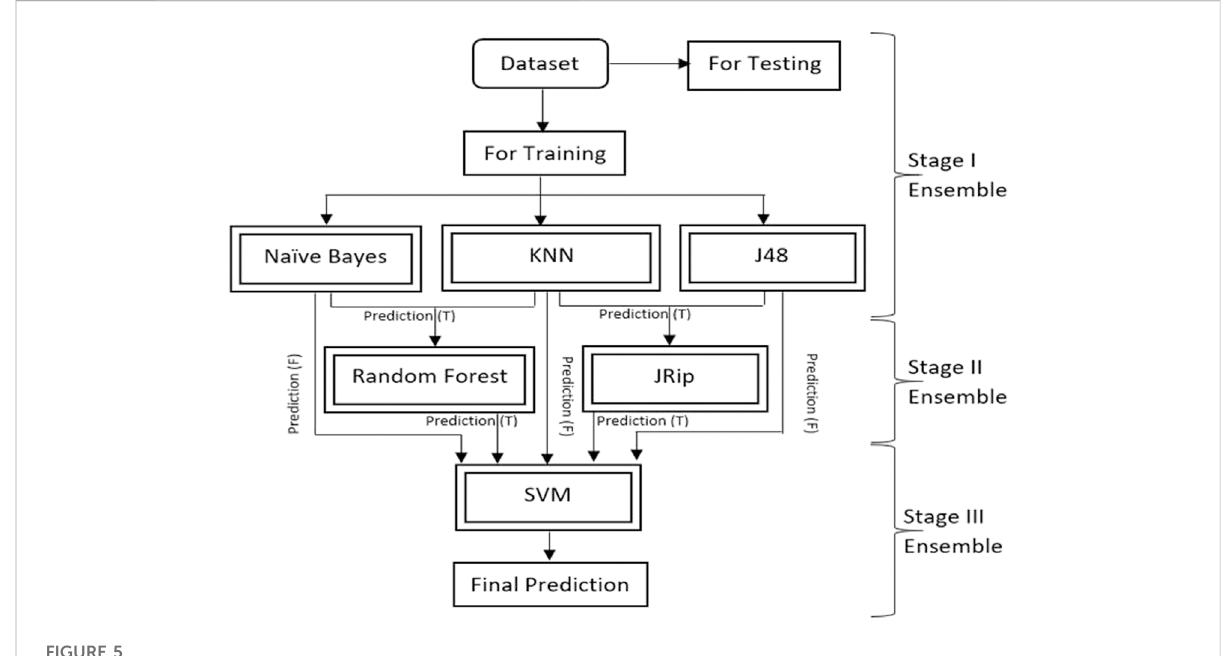
FIGURE 5 The proposed ensemble